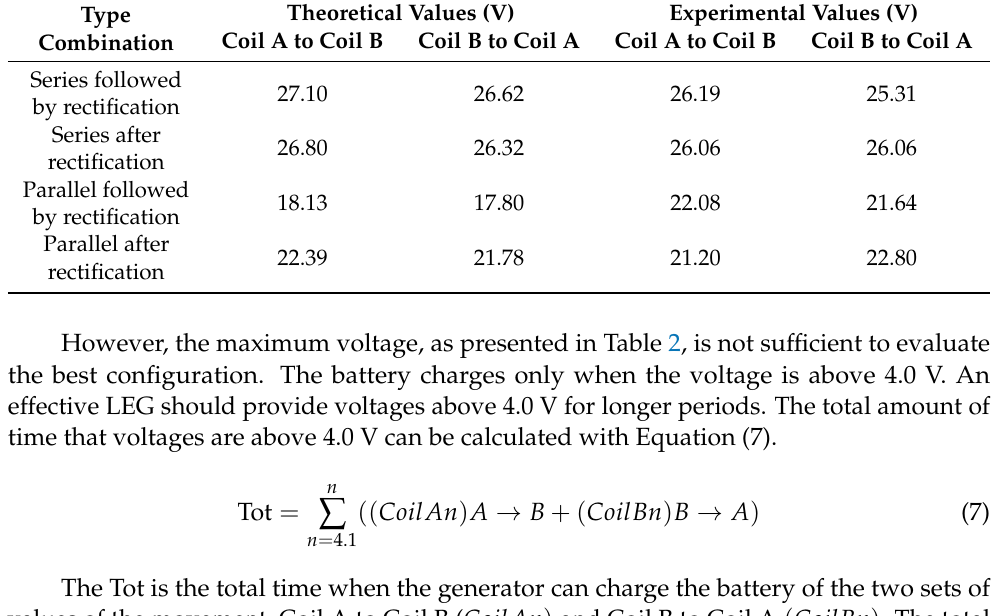
Figure 10. Calculated theoretical voltage (grey line) and experimentally measured voltage (red line) of the output, within a freefall movement from Coil A to Coil B ( left graph ) and from Coil B to Coil A ( right graph ), with coils parallelized after rectification.